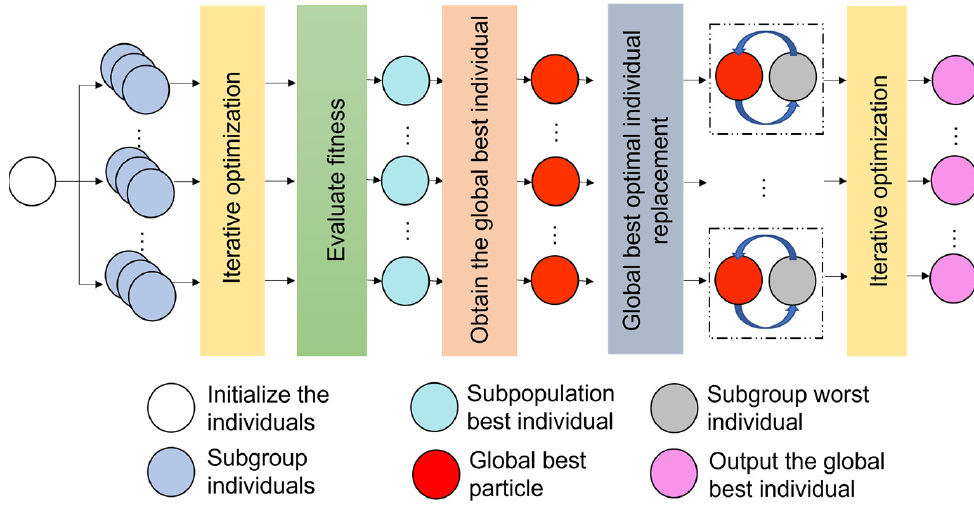
Figure 2. Execution flow of Strategy